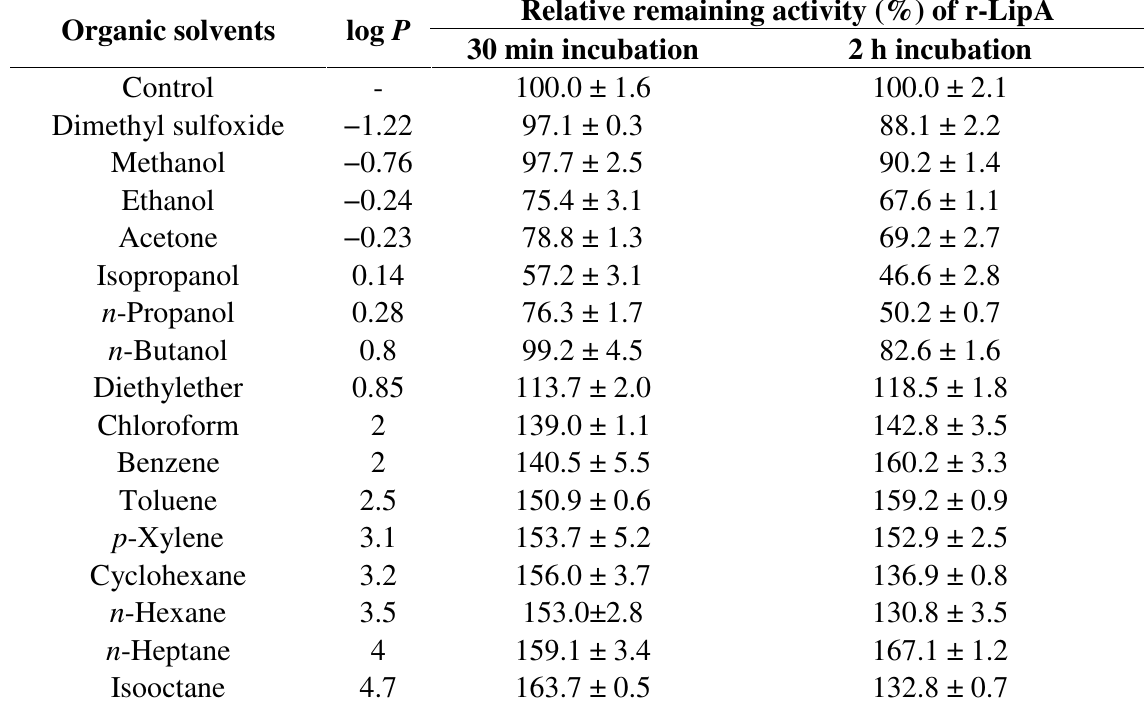
Table 3. Effects of various organic solvents on the activity of r-LipA. The reaction mixture contained 25% (v/v, i.e. , mixing 1 mL of organic solvent in 3 mL of the enzyme solution) organic solvents was incubated at 30 °C with shaking at 150 rpm for 2 h. After that, tolerance of the enzyme against solvent was assayed under standard conditions, and the remaining activity was expressed as the ratio to the lipase activity with distilled water instead of solvent. Values are means ± SD from three independent